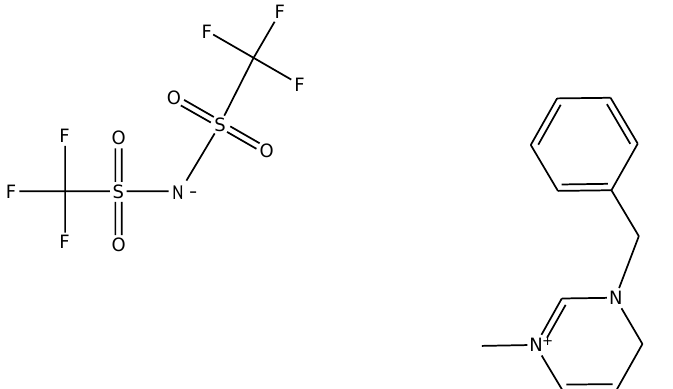
Figure 1. The material structure of 1-Benzyl-3-methylimidILlium bis (trifluoromethylsulfonyl) imide.